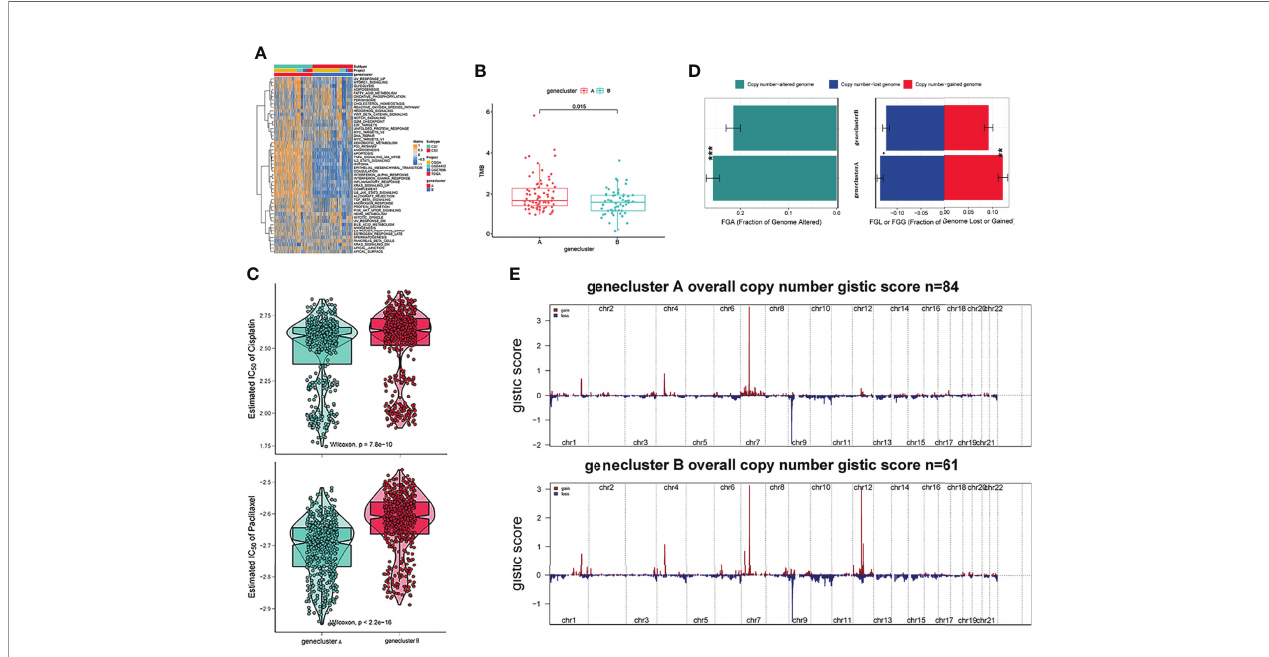
FIGURE 3 | Genetic alteration landscape among glioblastoma multiforme (GBM) genomic subtypes. (A) Heatmaps of 50 hallmark pathways with differential activation in different gene clusters. (B) The distribution of tumor burden mutations in different gene clusters. (C) Patients with gene cluster A are likely to receive greater bene fi t from cisplatin and paclitaxel treatment. (D) Fraction genome gain/loss (FGA/FGG) and fraction genome altered (FGA) distributions. Bar charts show the mean ± SEM. (E) The G score plot of the deleted or ampli fi ed genomic regions in gene clusters was determined using GISTIC 2.0. The G score was determined by multiplying copy numbers by the frequency across cases. (**p ≤ 0.01; ***p ≤